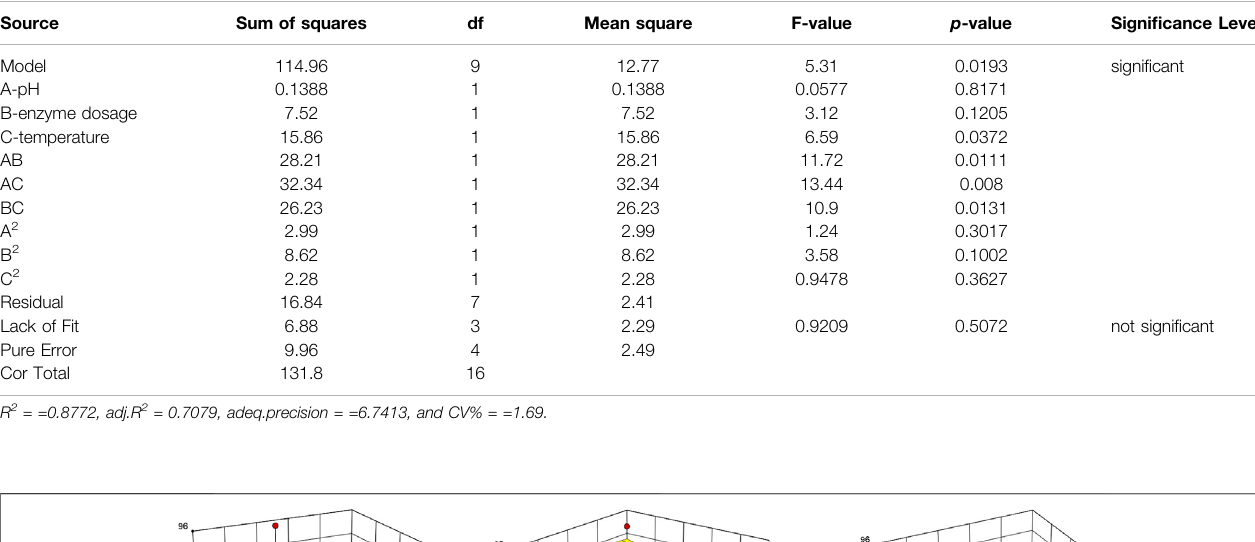
TABLE 3 | Analysis of variance for the fi tted regression equation.